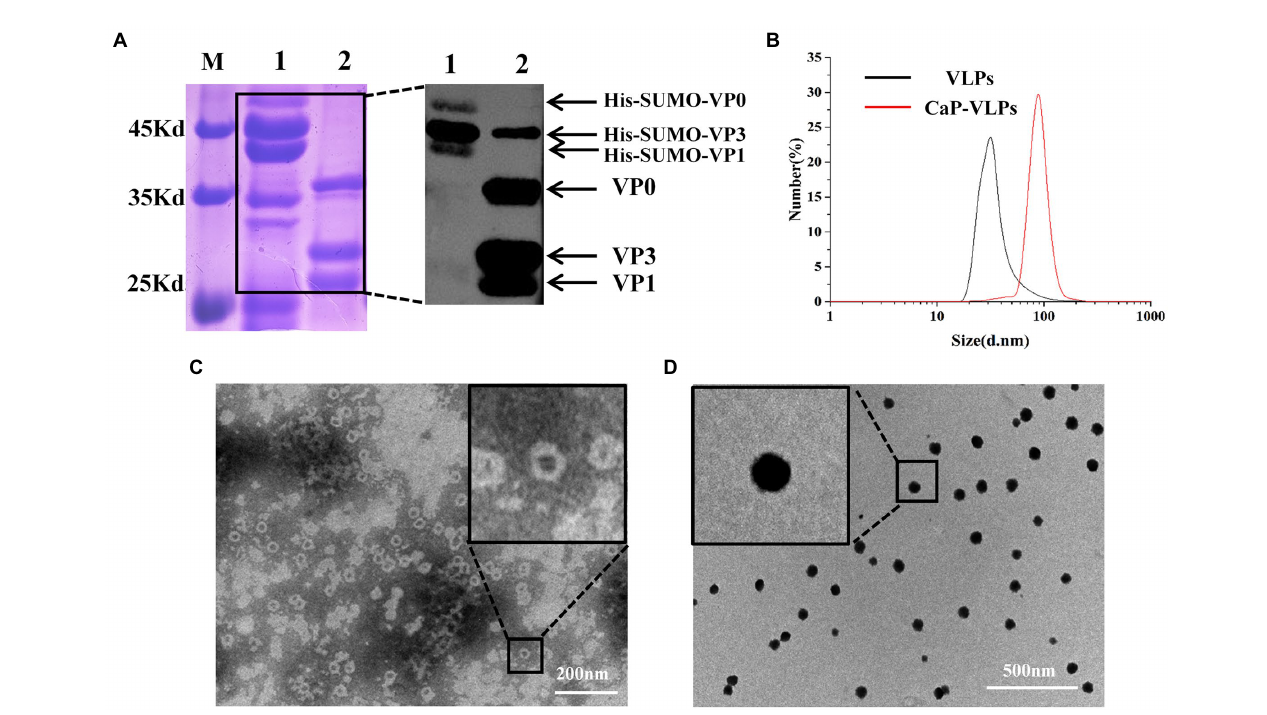
FIGURE 1 Characterization of mineralized FMD CaP-VLPs. (A) SDS-PAGE and Western blot analysis of FMD VLPs. Lane 1: FMD structural proteins with His-SUMO tag, lane 2: FMD VLPs. (B) Identification of FMD VLPs and FMD CaP-VLPs with dynamic light scattering (DLS). (C) Transmission electron microscopy (TEM) observation of FMD VLPs. (D) TEM observation of FMD CaP-VLPs.